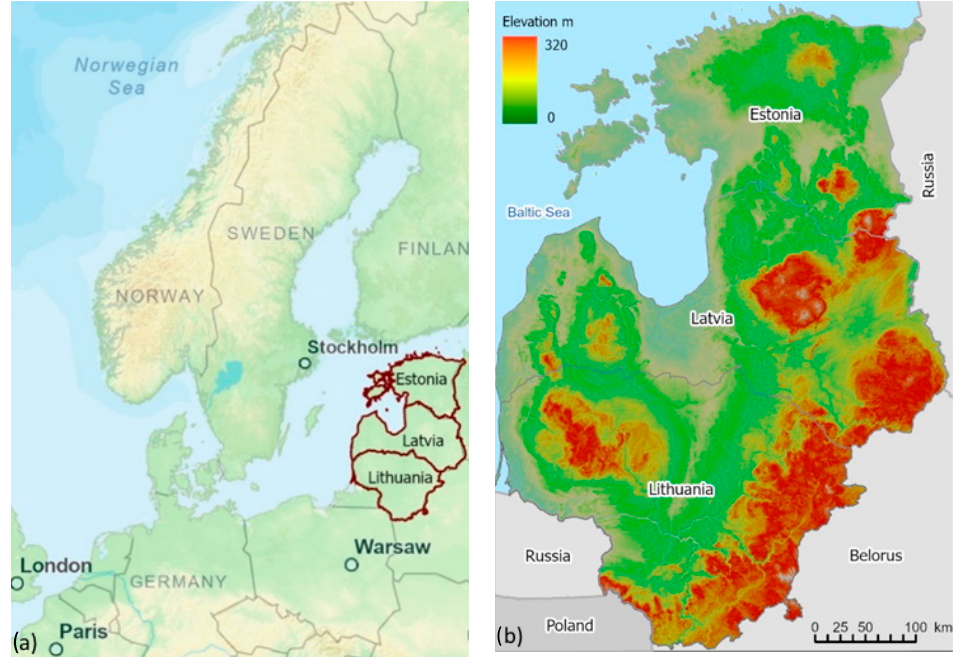
Figure 1. ( a ) Location of the Baltic States in the Baltic Sea region (Source: © Esri, open street map contributors), and ( b ) elevation map of the Baltic States (Source: © Esri, © USGS SRTM, open street map contributors).